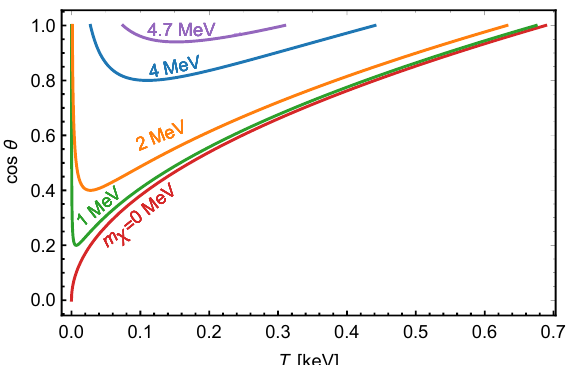
Figure 2 . Relation between cos (cid:18) and T . This (cid:12)gure is produced according to eq. (2.5) with M = 72 : 6 GeV (i.e. a Germanium detector) and E (cid:23) = 5 MeV. The case m (cid:31) = 0 has the same kinematics as the standard coherent elastic neutrino-nucleon